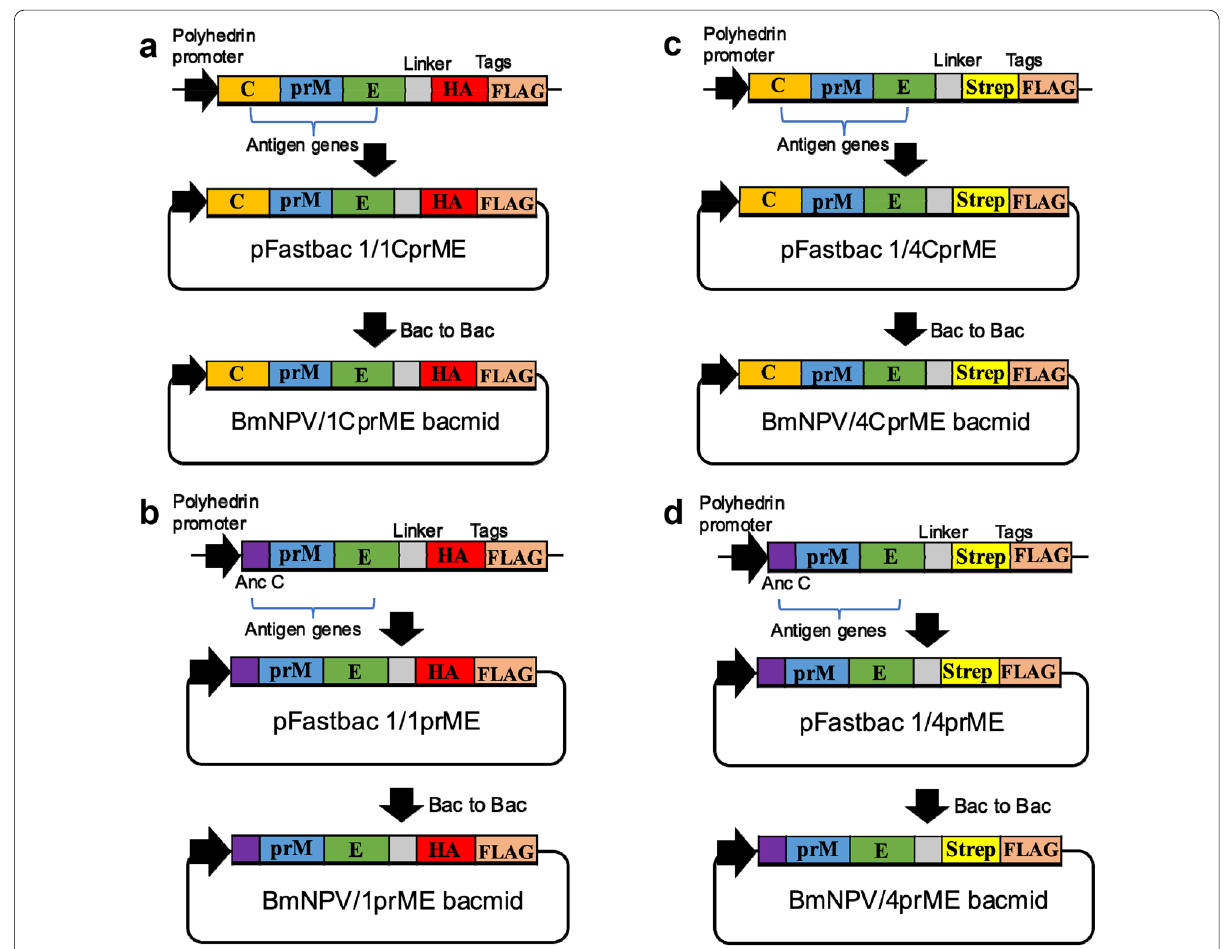
Fig. 1 Construction of recombinant dengue virus structural proteins expressed in this study. a 1CprME, b 1prME, c 4CprME, and d 4prME polypeptides of DENV-1 and 4 were expressed in silkworms as a fusion protein with HA